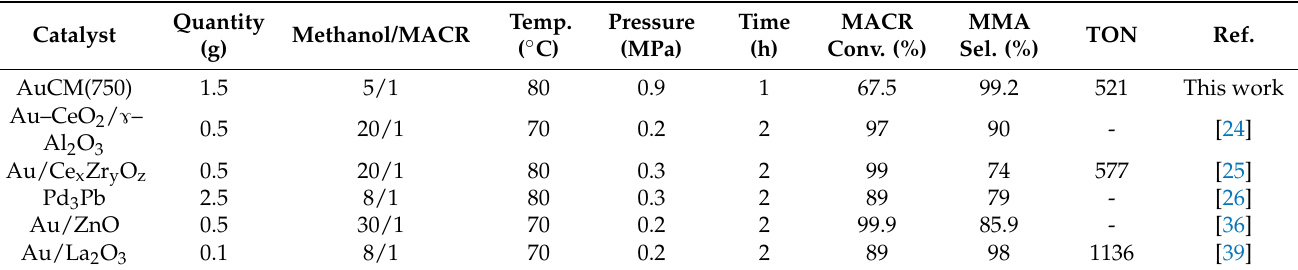
Table 3. Catalytic activity and reaction condition of AuCM(750) catalyst in comparison with the others reported in many literatures.